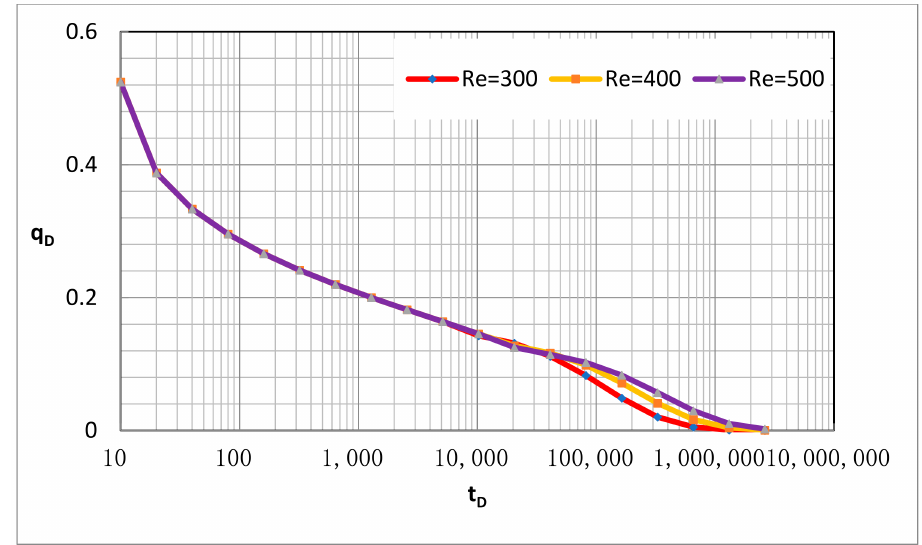
Figure 10. Production decline curve plate of closed boundary low-permeability reservoir with different outer boundary